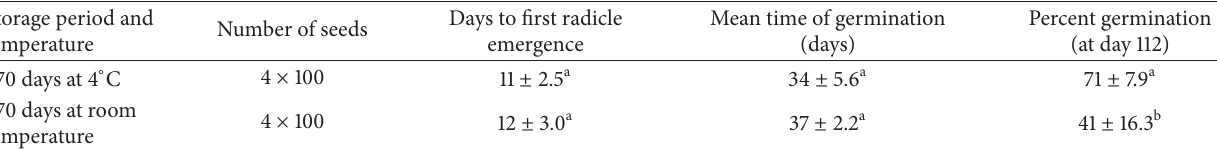
Table 4: The effect of storage temperature on the germination characteristics of Calluna vulgaris seeds under a photoperiod of 8 h and a temperature regime of 10 ∘ C. Mean values ± standard deviations. In each column, groups that showed significant differences ( 𝑃 < 0.05 ) are indicated with different